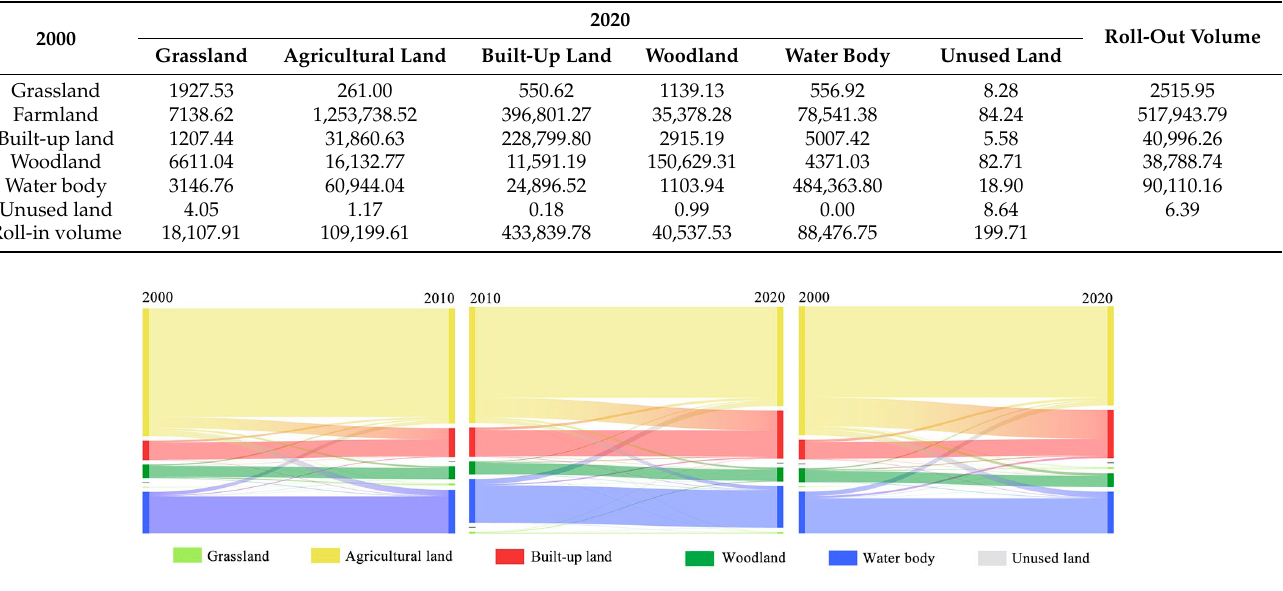
Figure 5. Land-use conversion map of southern Jiangsu from 2000 to 2020. Table 3. Land-use conversion matrix from 2000 to 2020 (hm 2 ).